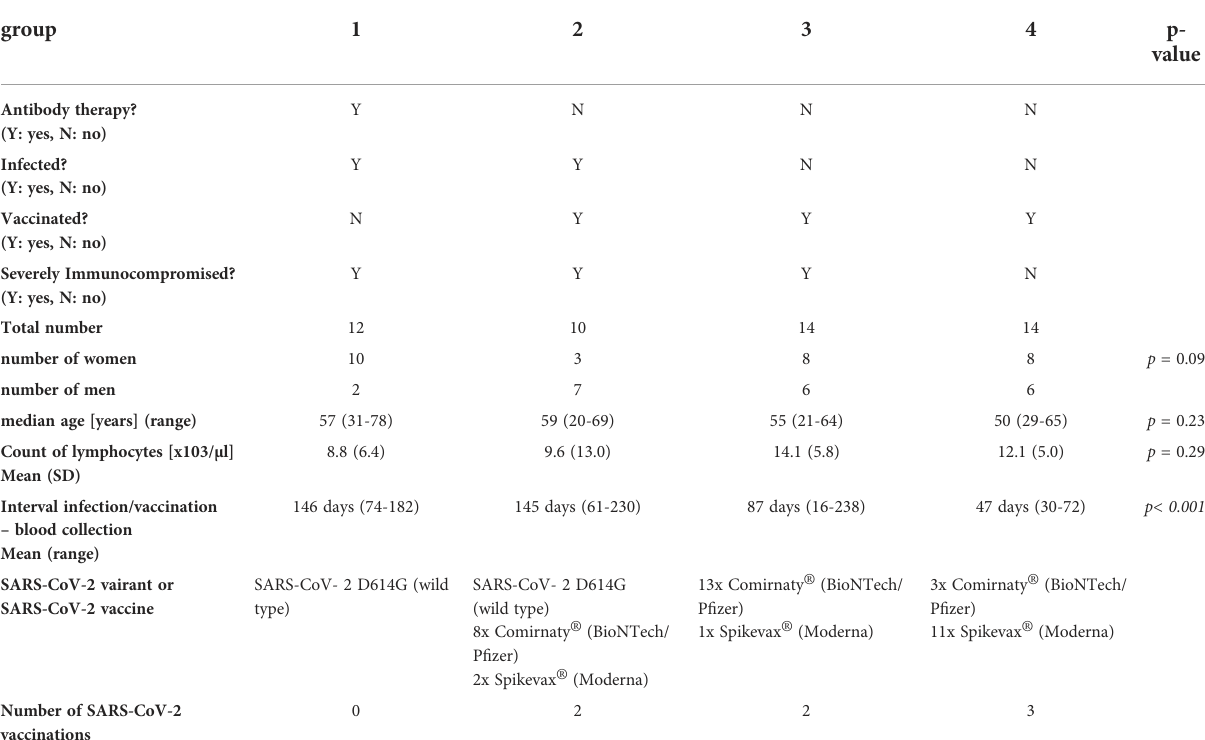
TABLE 1 Overview of the study cohort.